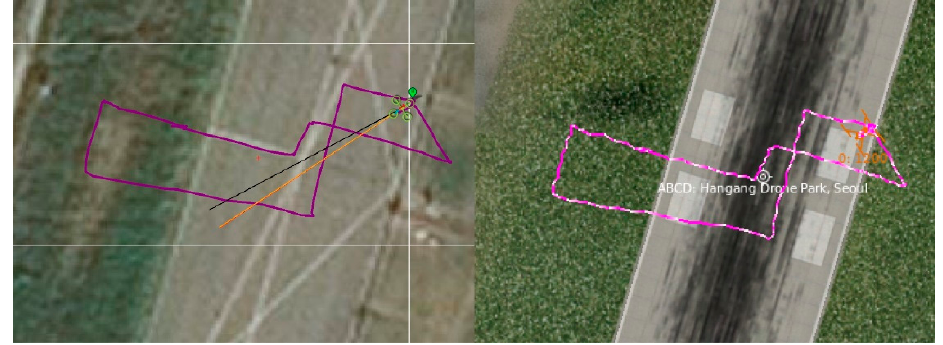
Figure 17. Flight Task 1, flight trajectory of the real ( left ) and the virtual quadcopters ( right ).